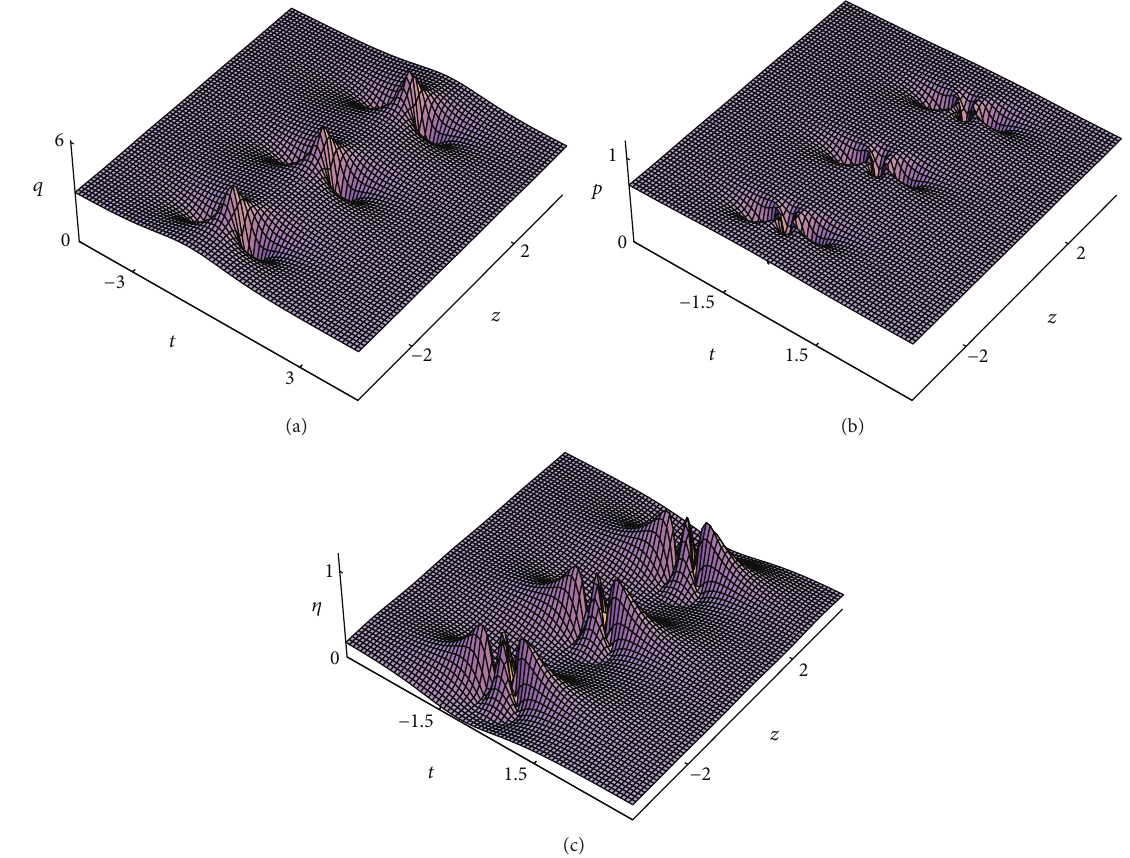
Figure 1: The parameters adopted here are 𝜅 𝑠 = 2.3 , 𝑞 𝑐 = 1 , 𝜅 𝑐 = 3 , 𝜔 = 1 , and 𝜏 = 0